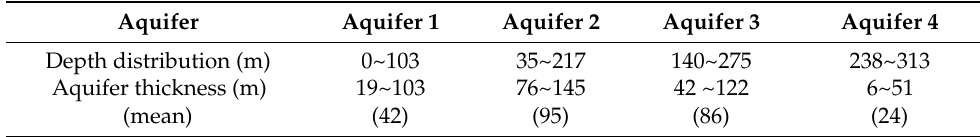
Table 1. Depth distribution of each of the 4 aquifers in the Zhuoshui River alluvial fan. Aquifer Aquifer 1 Depth distribution